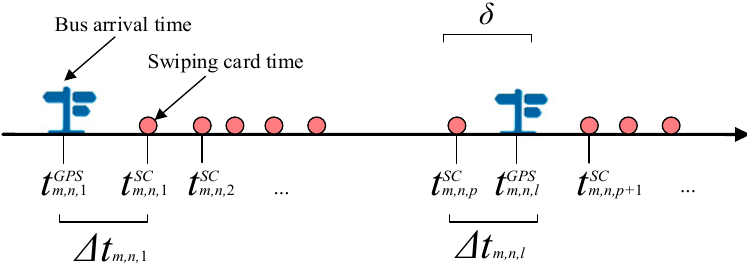
Figure 4. The sequence of card swiping time and bus arrival time.